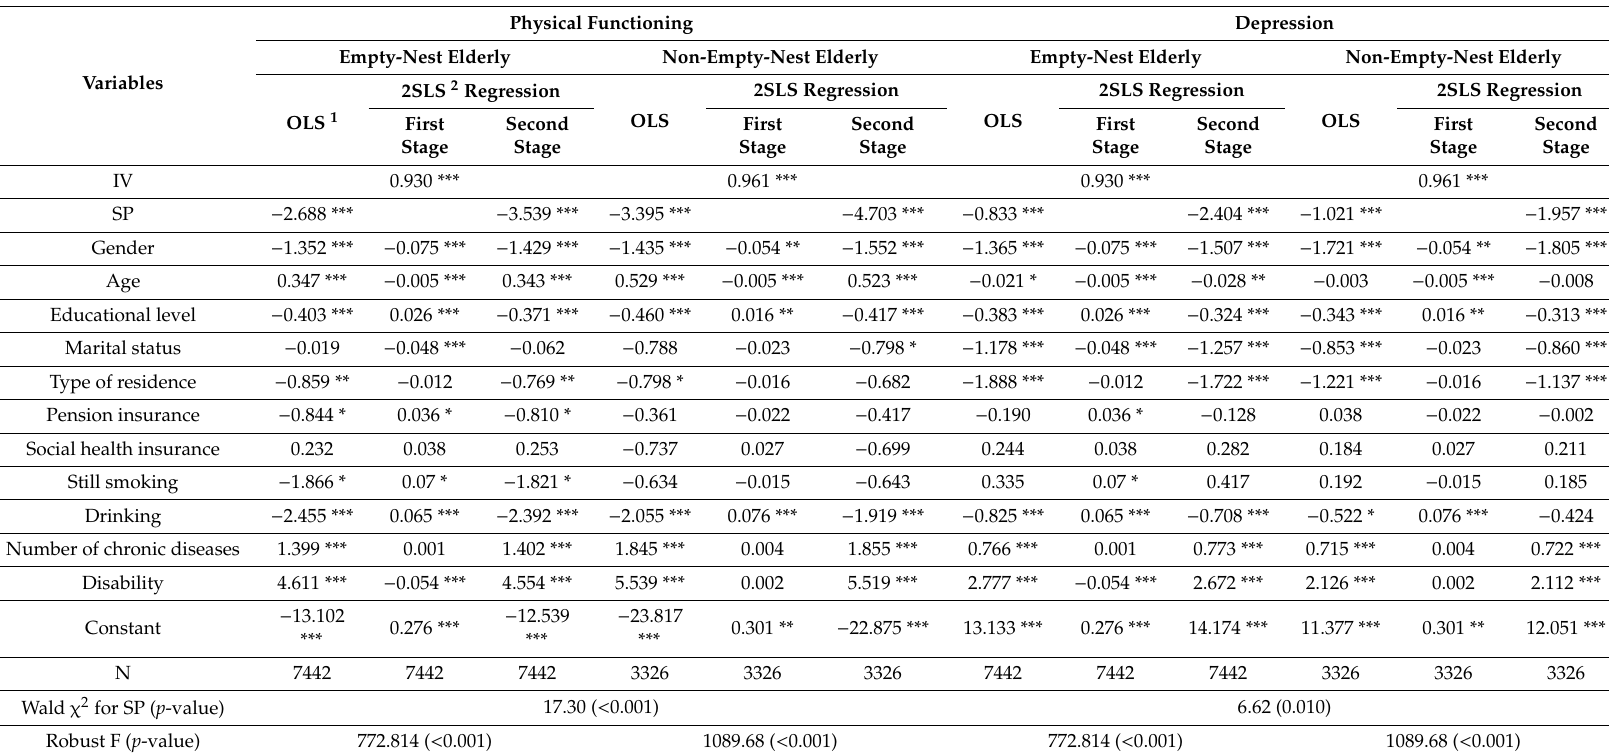
Table 2. Estimating the e ff ect of SP on the physical functioning and depression of empty-nest elderly using OLS and 2SLS regression.